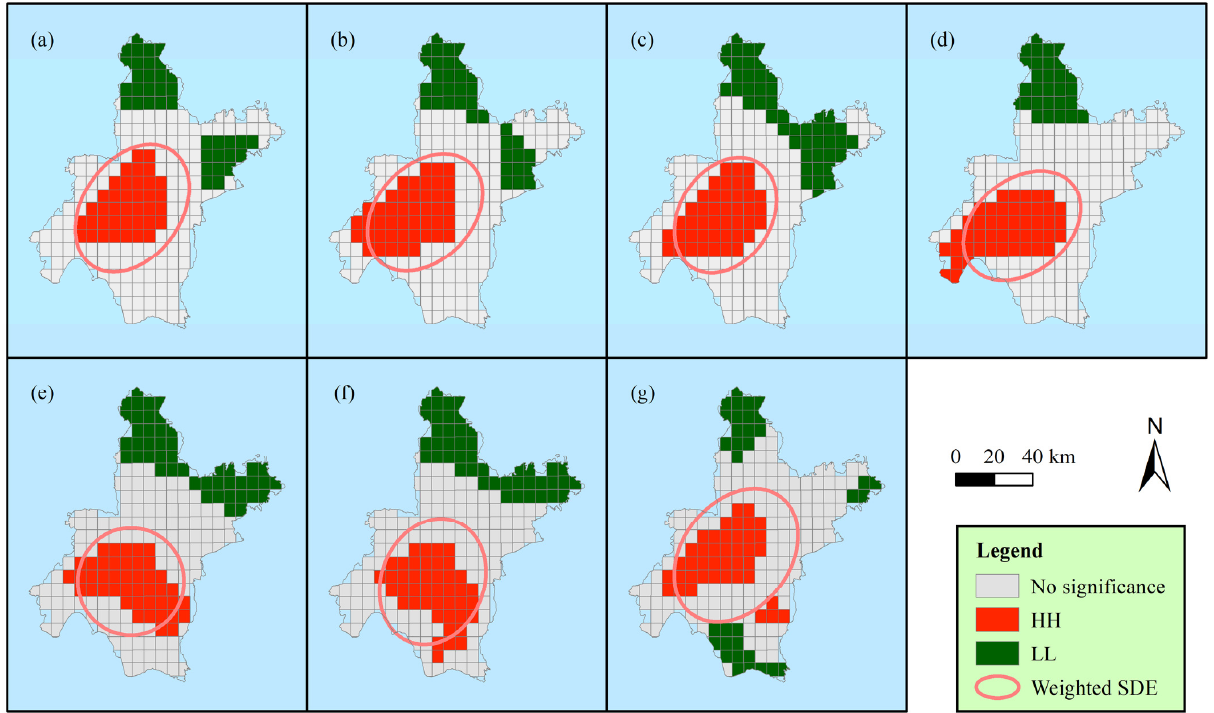
Figure 8. Local spatial pattern of the air temperature at 22:00 (significant level at 0.05). ( a ) 17 July;